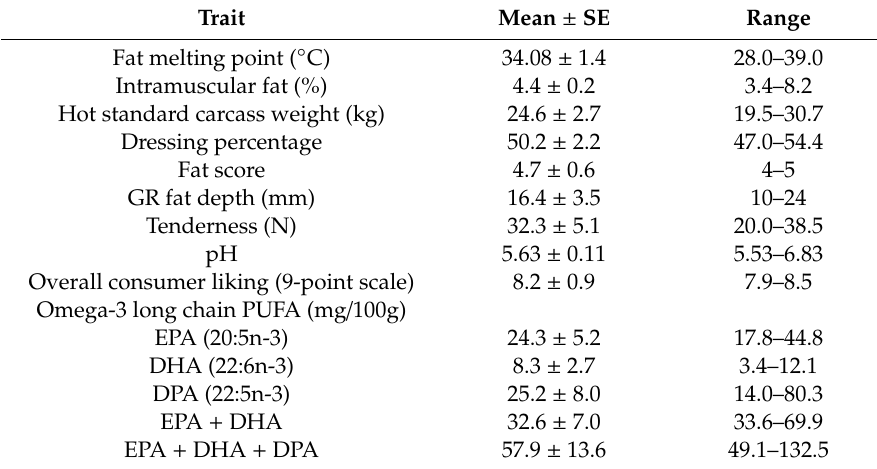
Table 1. Tattykeel Australian White carcass and meat quality characteristics ( n =